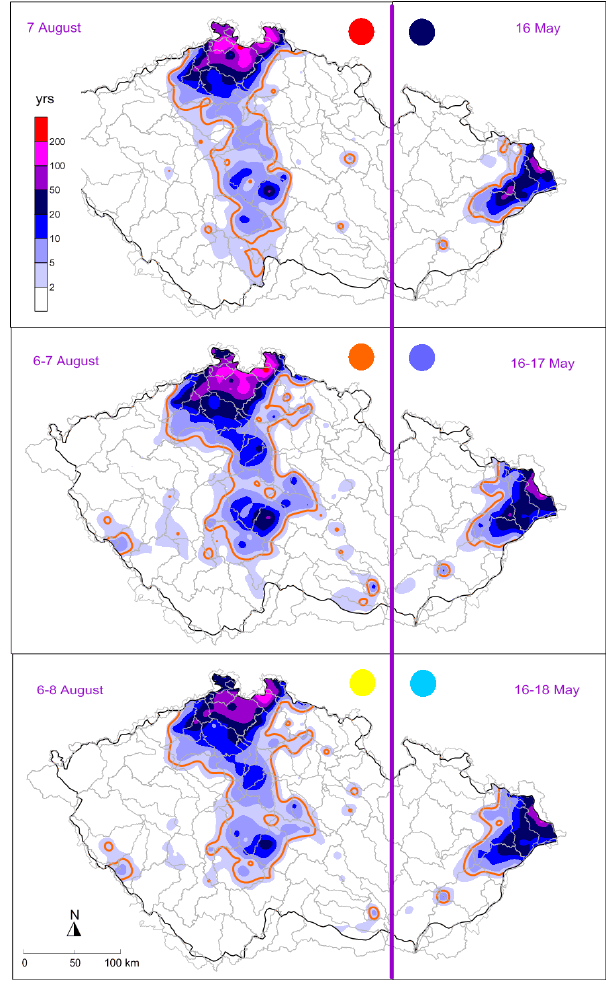
Fig. 3. Return periods of precipitation totals in May 2010 and in August 2010 (the right and left part of the figure, respectively), interpolated into the 1km grid. Each event is represented by a 1-day, 2-day, and 3-day period with maximum return periods. The optimized areas affected in the given time period (see Sect. 4.3) are depicted by orange lines. Colors of circles correspond with Figs. 4, 5, 6, and 7.